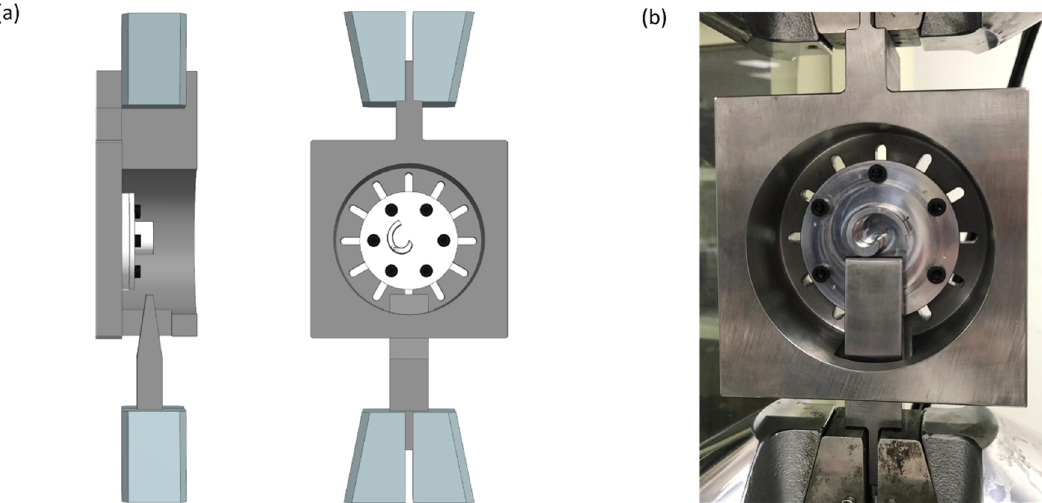
Figure 4. Application of test equipment reprinted from [20]; ( a ) C-specimen and fatigue test jigs and ( b ) jig assembly mounted on the servo hydraulic test machine, Model 810 from MTS (Eden Prairie, MN, U.S.A.).